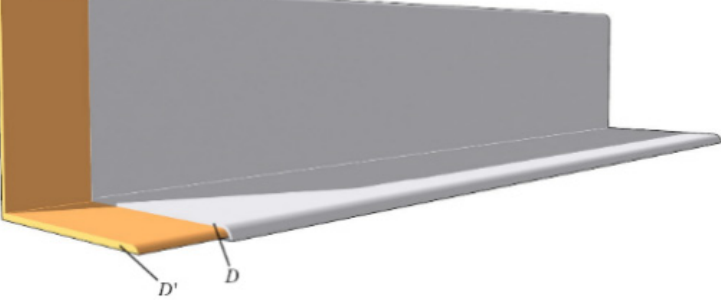
Figure 17. Cross-section of a corroded angle. Table 3. Residual depth of corrosion D’ of the angle sections in the I–M atmosphere (unit: mm). Steel Type Angle